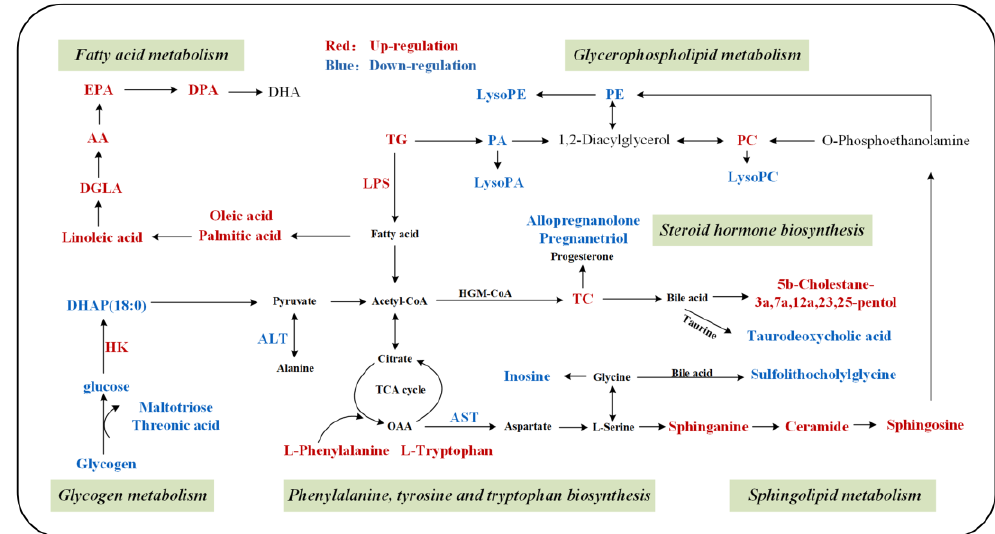
Figure 5. The hepatic metabolic pathway network based on the KEGG database during the sexual maturation of female rainbow trout. Red and blue represent hepatic metabolites that statistically significantly increased and decreased, respectively.